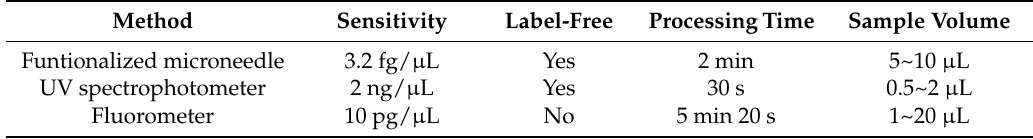
Figure 5. Electrical measurement results, with error bars showing standard deviation, for ( a ) the bare microneedle and ( b ) the functionalized needle at 1.1 V. Upon presence of DNA on the microneedle sensor surface, the current is decreased; ( c ) Fluorescence measurement results with bars showing standard deviation, for the functionalized microneedle. Fluorescence signal increased with increasing DNA concentrations; ( d ) Fluorescence images for control, 100 aM, 10 fM, and 1 pM. Table 1. Comparison between our functionalized microneedles and the conventional methods [21].